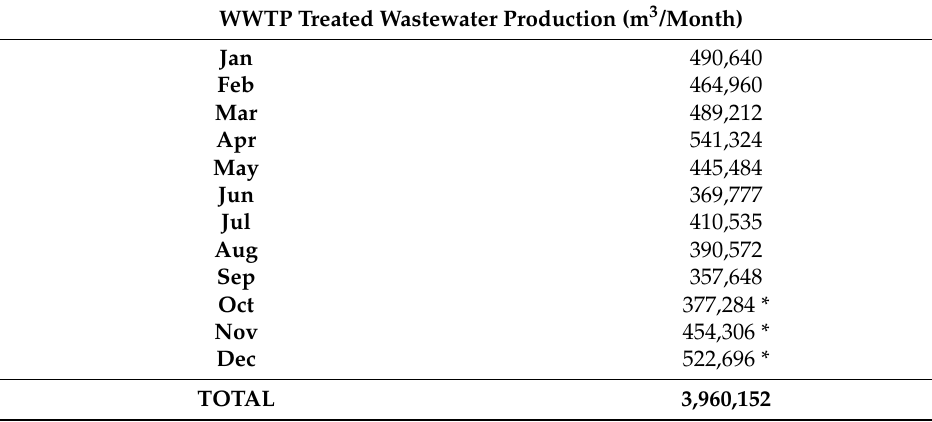
Figure 2. Schematic configuration of Espinho WWTP. Table 2. Treated wastewater in Espinho WWTP in